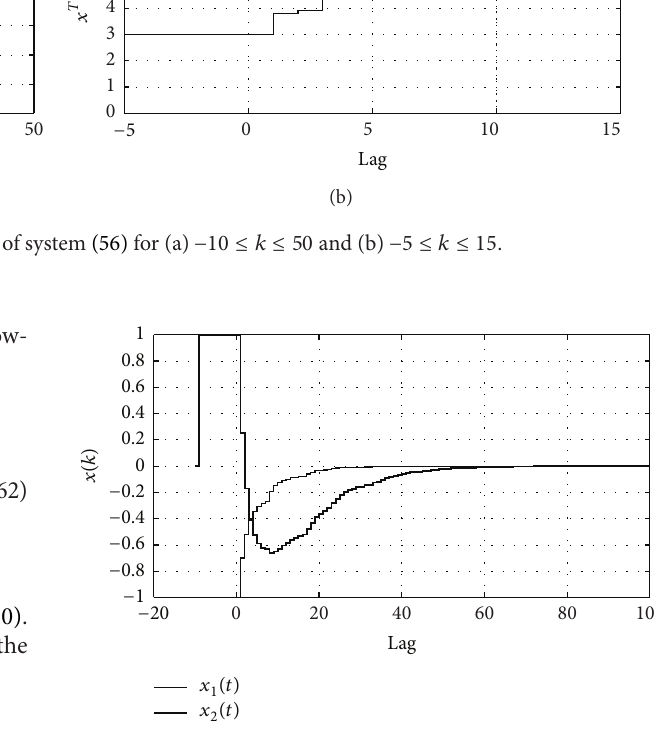
Figure 4: Initial state responses of system (60) with time-varying delay 2 ≤ 𝑑(𝑘) ≤ 10